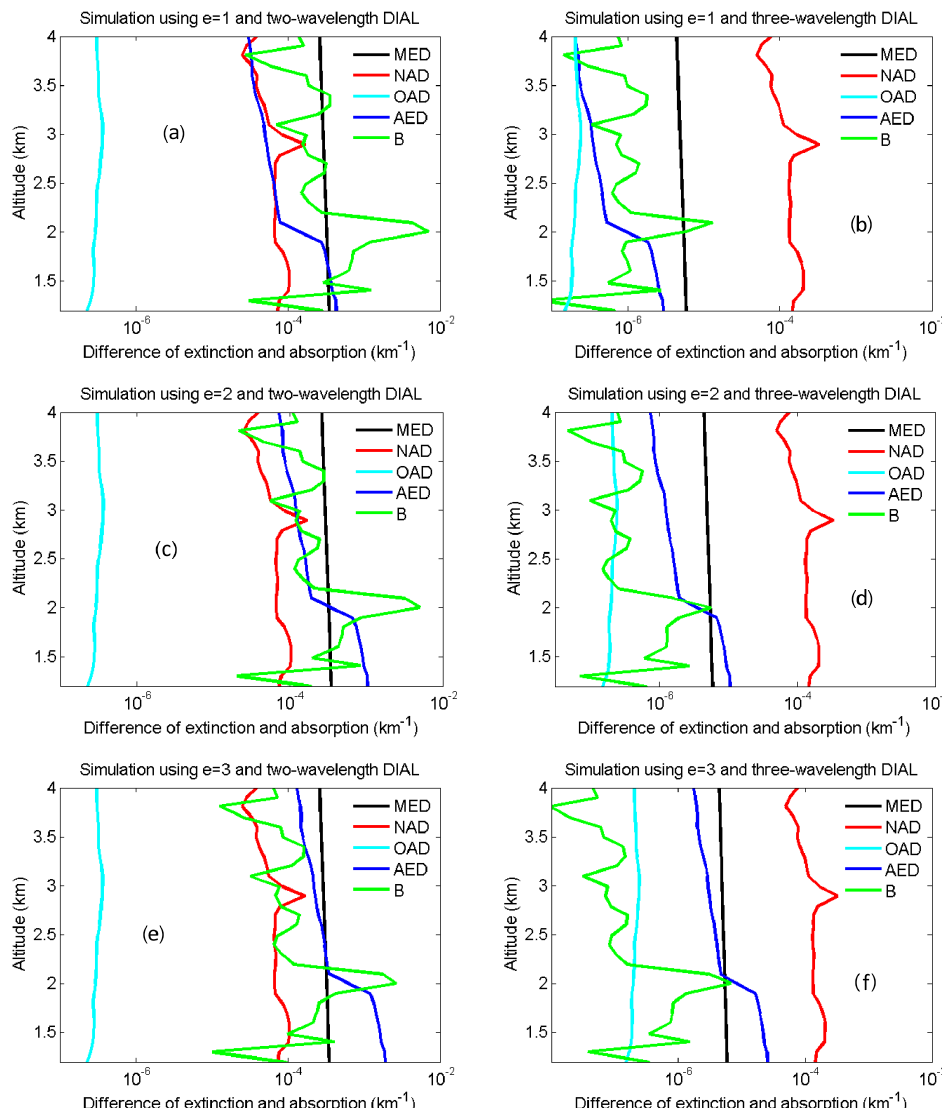
Figure 6. Simulated MED (black), NAD (red), OAD (light blue), AED (deep blue) and B (green) using the two-wavelength DIAL technique with e = 1 (a) , e = 2 (c) and e = 3 (e) and the three-wavelength DIAL technique with e = 1 (b) , e = 2 (d) and e = 3 (f)